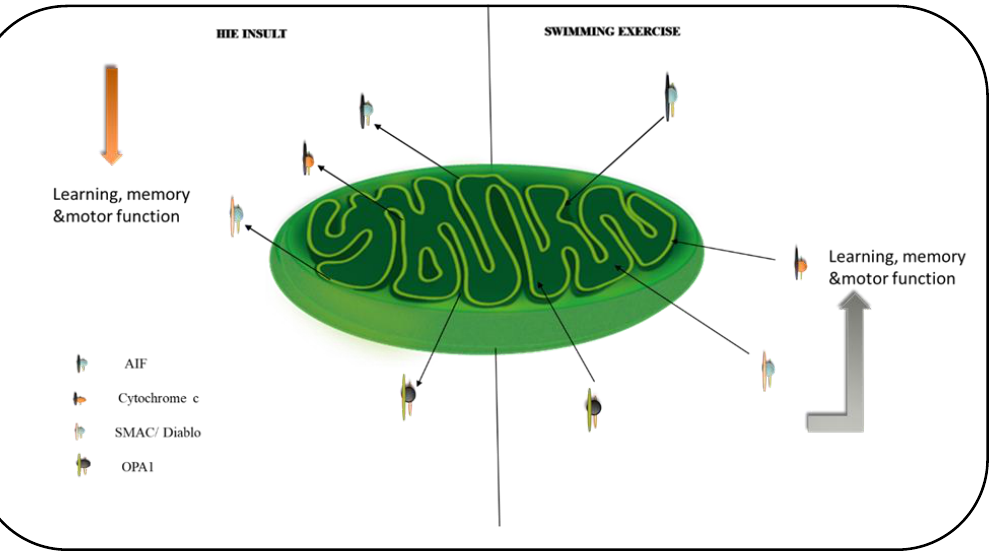
Figure 7. A schematic summary of the effect of exercise on mitochondrial proteins in the brain. Exercise downregulates the translocation of the proteins to the cytosol and nuclei of the hippocampus and cortex. This stabilizes the mitochondria and mediates exercise’s positive effects on learning, memory, and motor function.